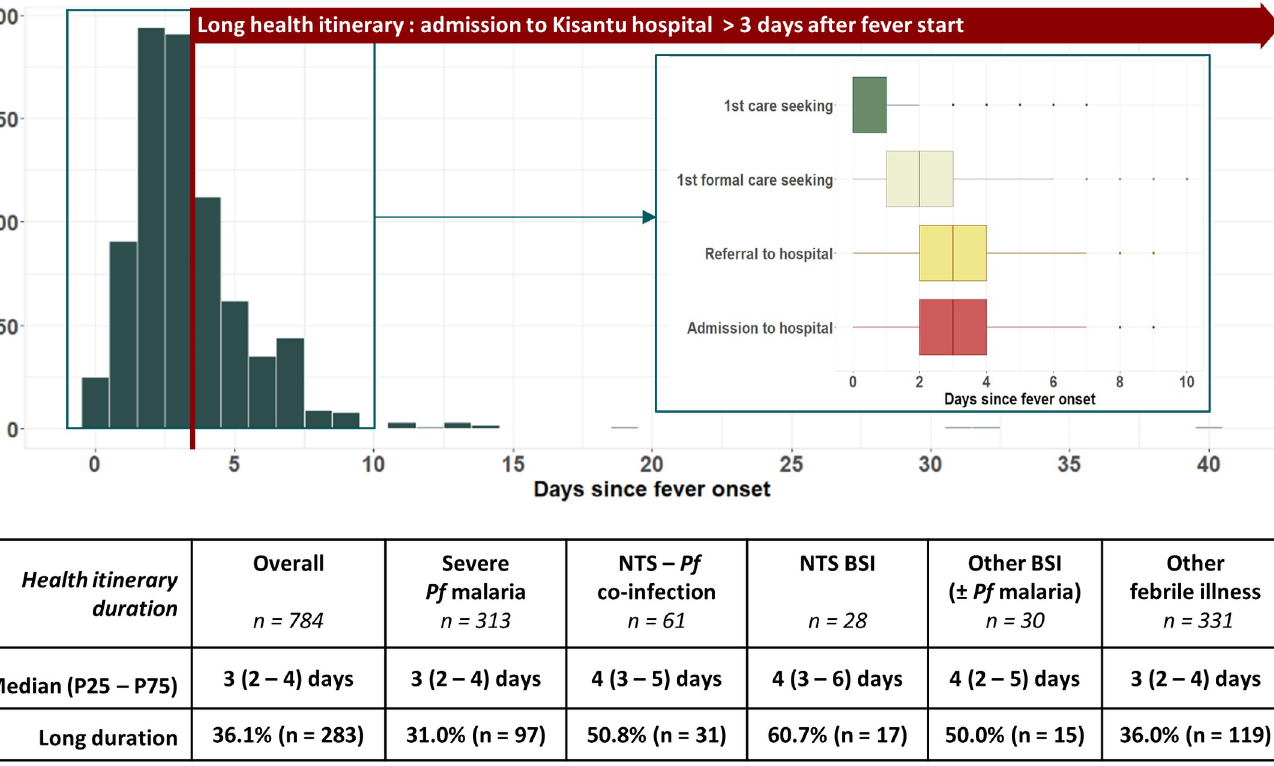
Fig 3. Duration of health itinerary and timing of healthcare seeking sequence of children under-five admitted to Kisantu hospital with severe febrile illness. Left panel: histogram displaying the duration of health itinerary of all enrolled children (n = 784), right panel: boxplot representation to follow the timing of first (formal) healthcare seeking, referral and admission of children admitted within 10 days of fever onset (n = 771). Abbreviations: BSI: bloodstream infection; NTS: non-typhoidal Salmonella; Pf : Plasmodium falciparum